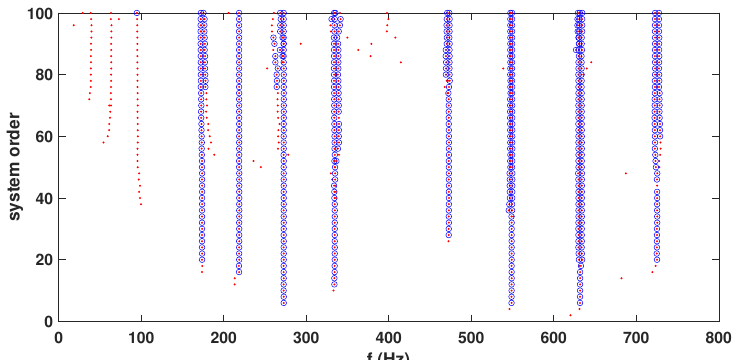
Figure 11. Stabilization diagram of test 1 of all three channels.